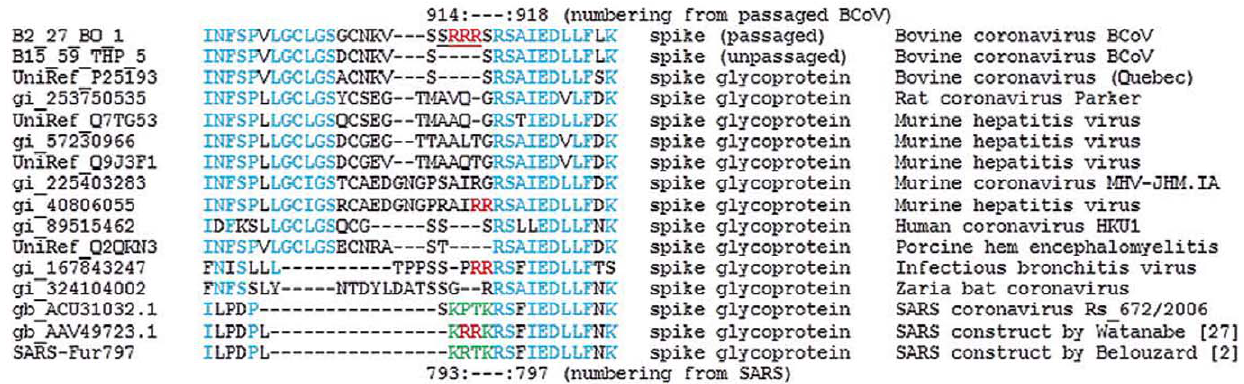
Figure 4. Multiple sequence alignment of BCoV insert region compared with that of other coronaviruses. Sequence region (894–927) including insert SRRR from the passaged BCoV (B2.27.BO.P1) was aligned with other coronavirus spike protein amino acid sequences. The inserted amino acids are underlined; amino acids conserved among coronavirus species are in blue text; RR motifs observed in other sequences are in red. In green is highlighted 793-KPTKR-797 region in SARS-CoV S2 domain described as a furin cleavage site allowed trypsin-independent cell-cell